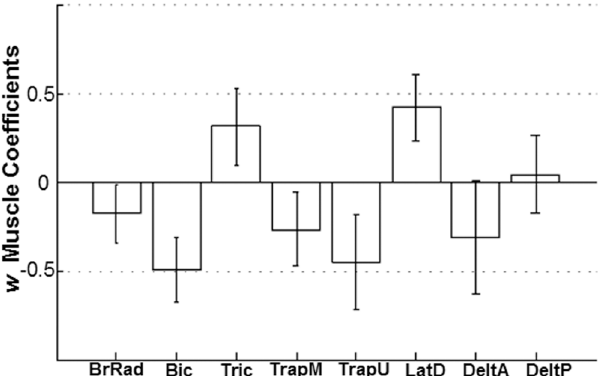
Fig 5. W coefficients per each muscle. Mean w coefficients for each muscle ± SD across subjects. Coefficient values represent an estimate of the sensitivity of each muscle to be modulated by the changes in the external forces. Positive values correspond to joint extensor modulations in response to changes in the upward external force. Negative coefficients quantified the correspondence between joint flexor muscles and external force